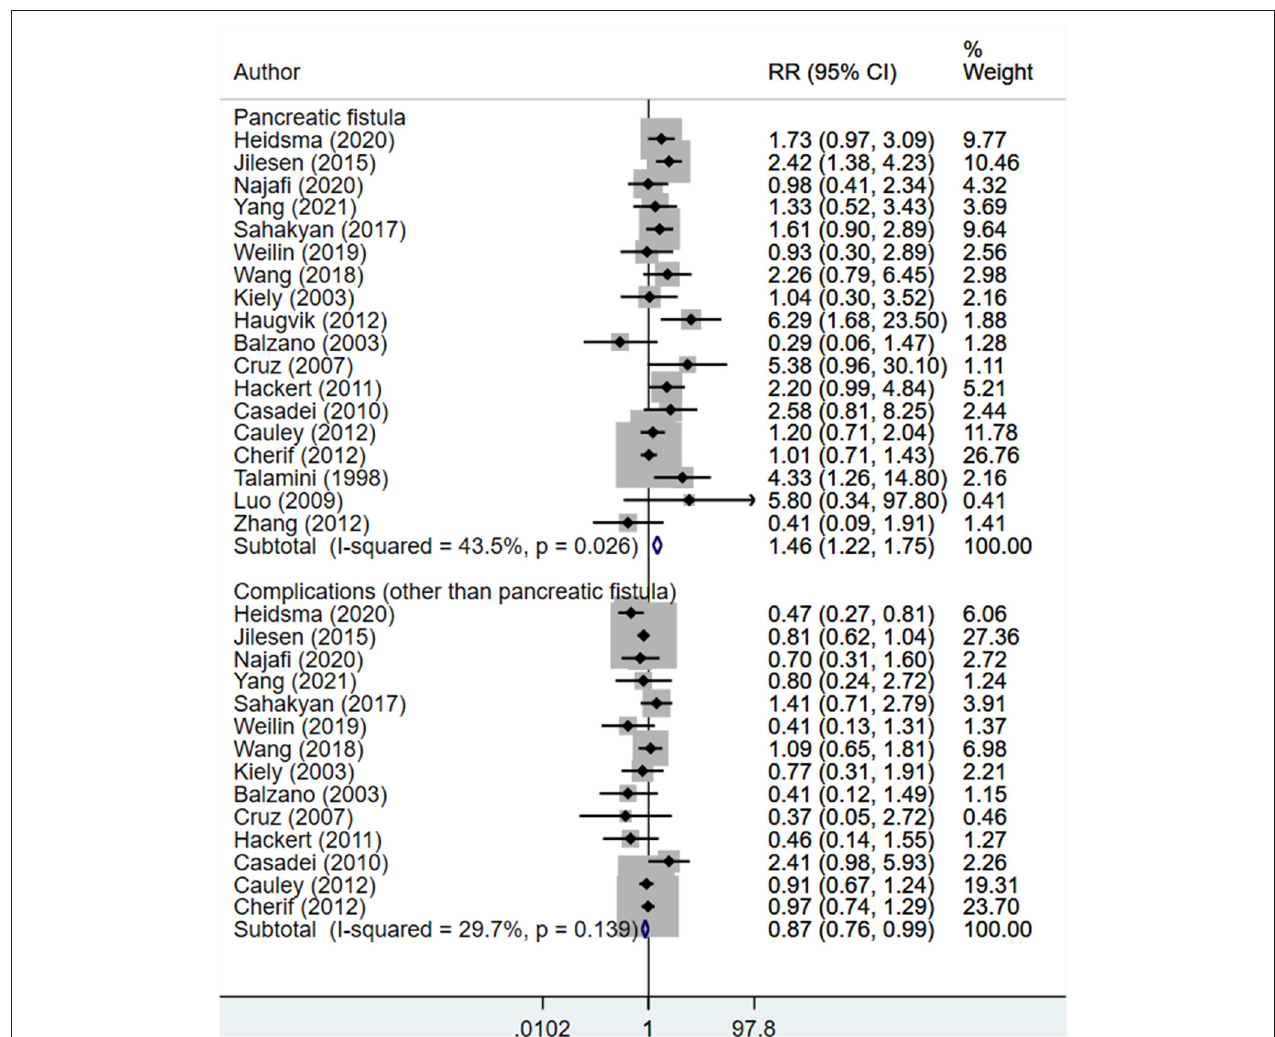
FIGURE 6 | Comparison of risk of complications between enucleation and standard surgical